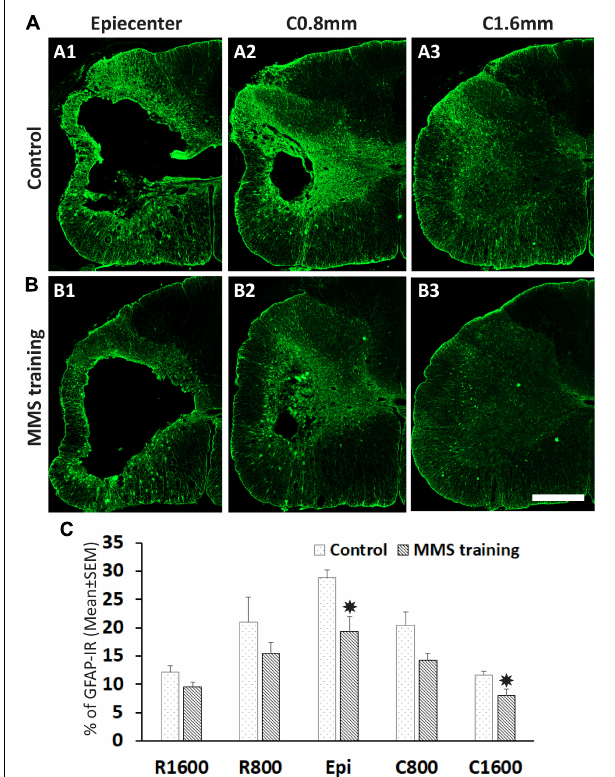
FIGURE 6 | Effect on astrogliosis after Modified Montoya Staircase (MMS) rehabilitation. Representative glial fibrillary acidic protein (GFAP)-immunoreactive (IR) images of spinal cord at epicenter, 0.8 and 1.6 mm caudal to the injury epicenter were taken from the rat without rehabilitation (A1–A3) or with MMS rehabilitation (B1–B3) . The quantification showed that MMS rehabilitation significantly decreased the percentages of GFAP-IR areas to total spared areas at the epicenter and 1.6 mm caudal to the epicenter [ (C) , p = 0.011 and 0.032, respectively]. Results in (C) represent mean ± standard error of the mean (SEM); n = 5 in each group. Scale bar = 200 µ m (A,B) . * P < 0.05. FIGURE 7 | Effect on neuroinflammation and spared white and gray matters